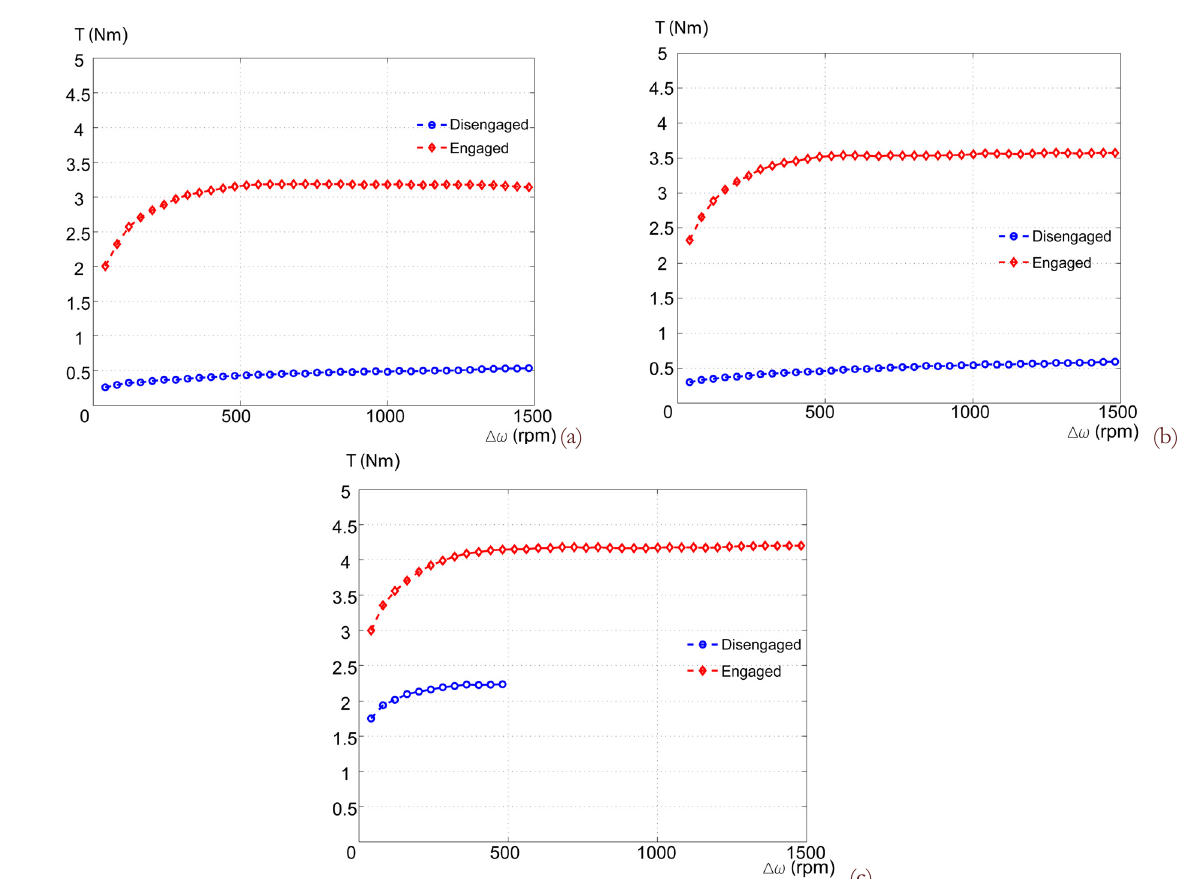
Figure 9: Prototype torque characteristics.